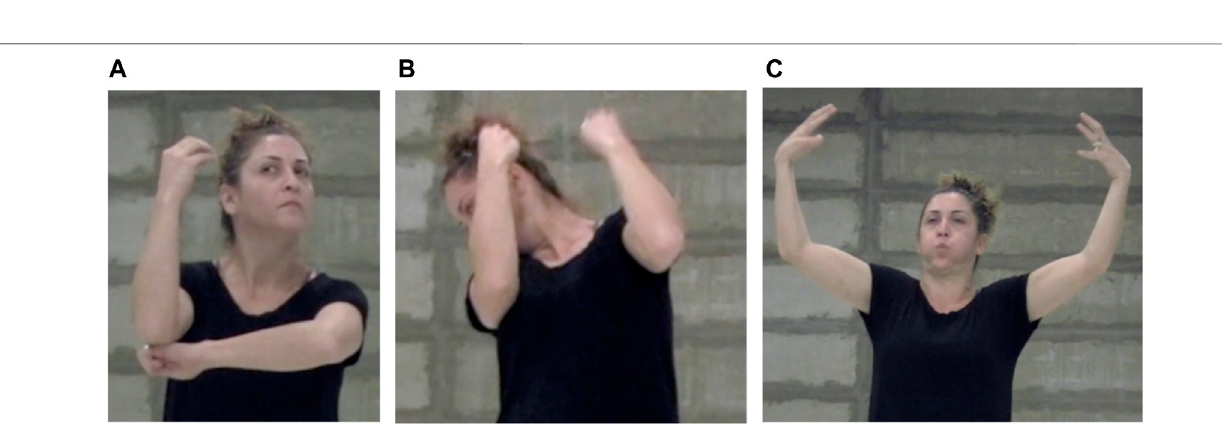
Frontiers in Communication |